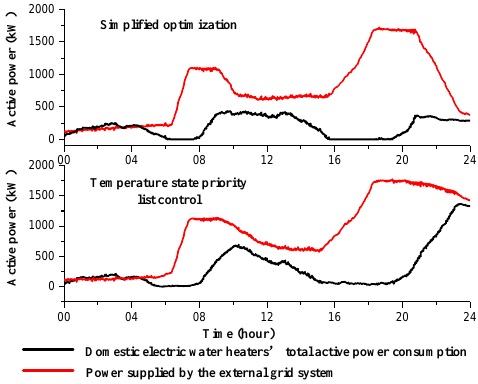
Figure 10. Optimization results of the simplified temperature state priority list and the temperature state priority list control